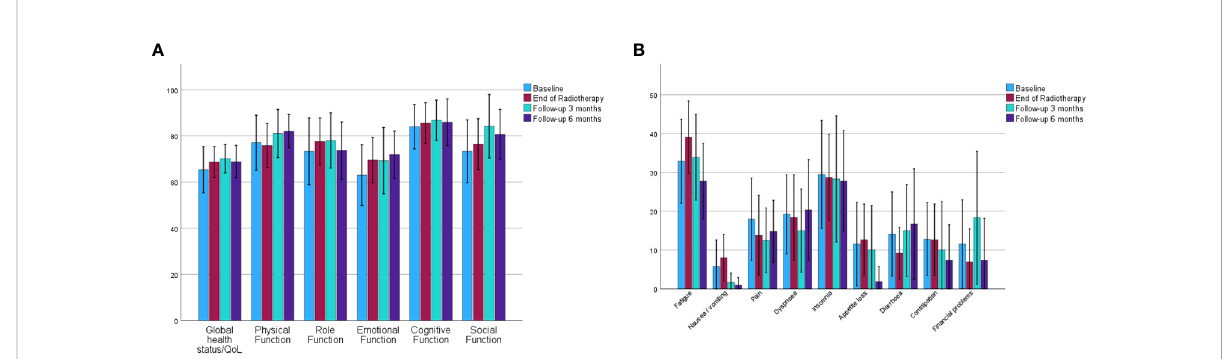
Van Dams et al. Ugurluer et